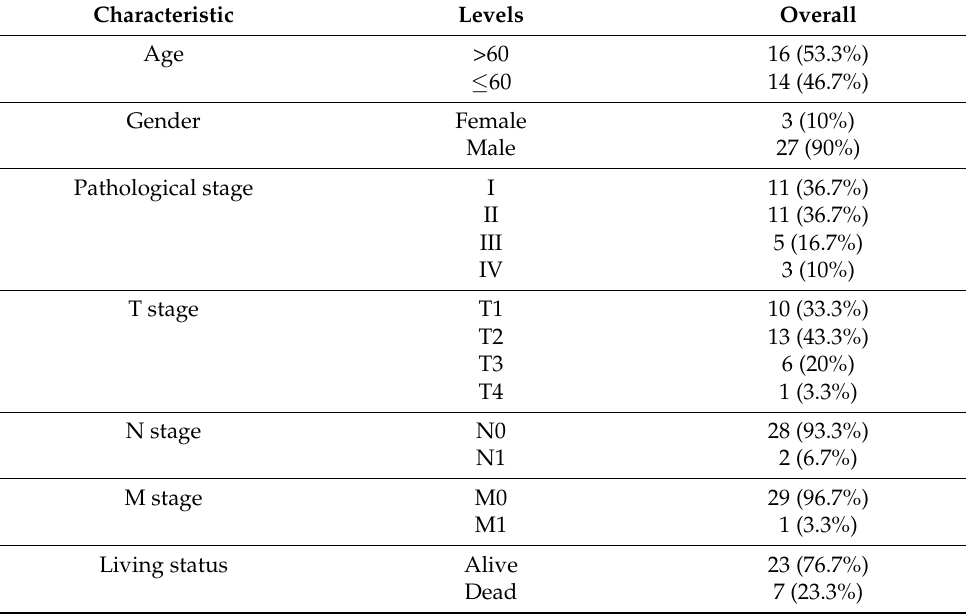
Table 1. Clinical information of HCC patients from Xiangya